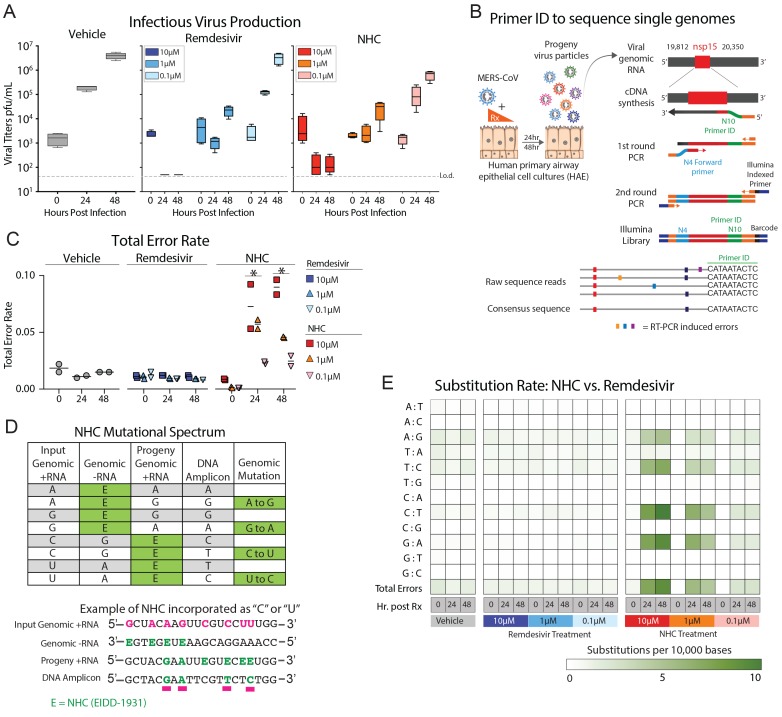
NHC antiviral activity is associated with increased viral mutation
rates. (A) HAE cultures were infected with MERS-CoV red
fluorescent protein (RFP) at an MOI of 0.5 in duplicate in the presence of vehicle,
RDV, or NHC for 48 hours, after which apical washes were collected for virus
titration. Data are combined from two independent studies. The boxes encompass the
25th to 75th percentile, the line is at the median, while the whiskers represent the
range. (B) Schematic of Primer ID deep sequencing for single RNA genomes
of MERS-CoV. (C) The total error rate for MERS-CoV RNA isolated from
cultures in panel A as determined by Primer ID. Error rate values are #
mutations per 10,000 bases. Asterisks indicate significant differences as compared to
untreated group by two-way ANOVA with a Dunnett’s multiple comparison test.
(D) Description of potential NHC mutational spectra on both positive
and negative sense viral RNA. (E) Nucleotide transitions in cDNA derived
from MERS-CoV genomic RNA.